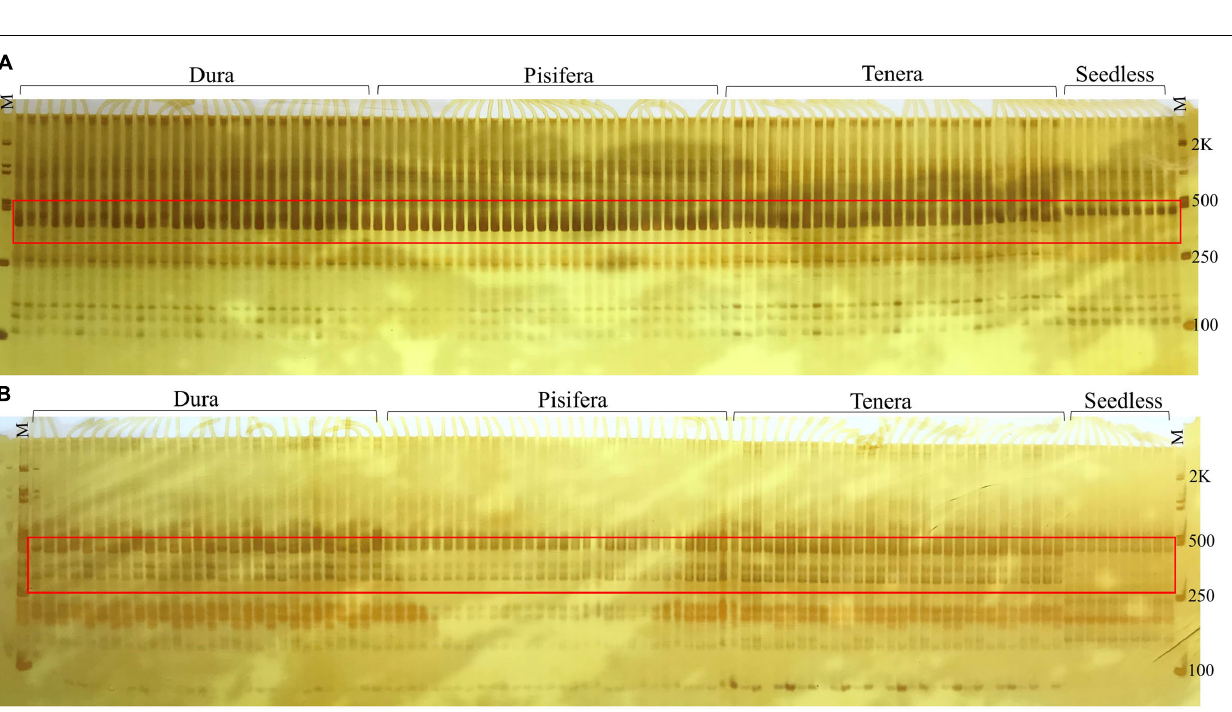
Frontiers in Plant Science |